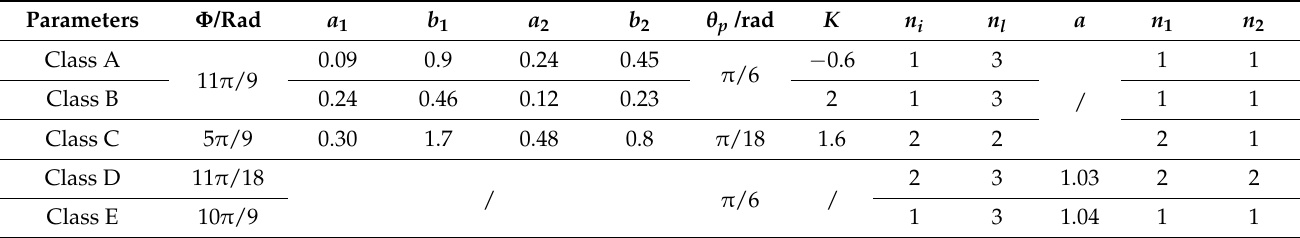
Table 4. Structural parameters of each